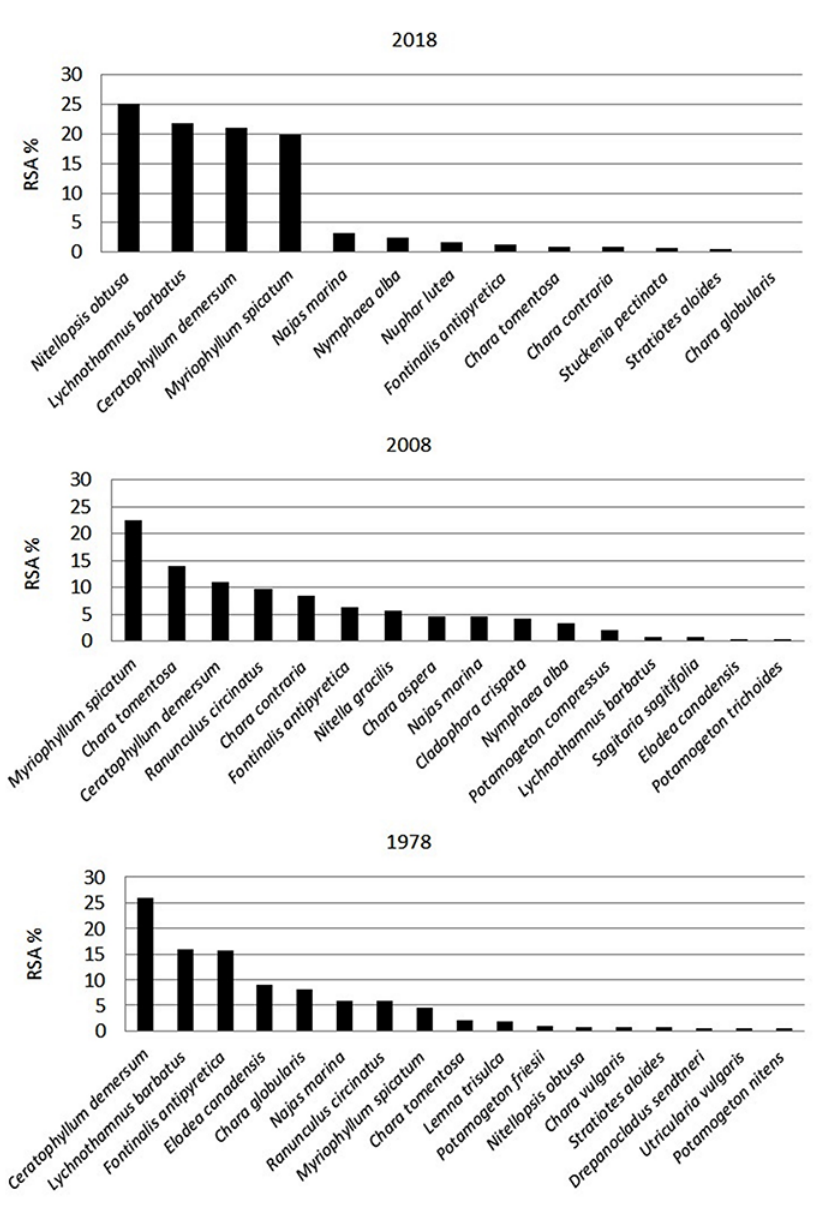
Figure 3 Relative species abundance (RSA, %) of taxa identified in Lake Kuźnickie in the summer seasons of 1978, 2008, and 2018. To calculate RSA the following data were processed: 1978 – Gołdyn (1983); 2008 – monitoring data of Voivodship Inspectorate of Environmental Protection in Poznań (VIEP in Poznań, 2008); 2018 – this original